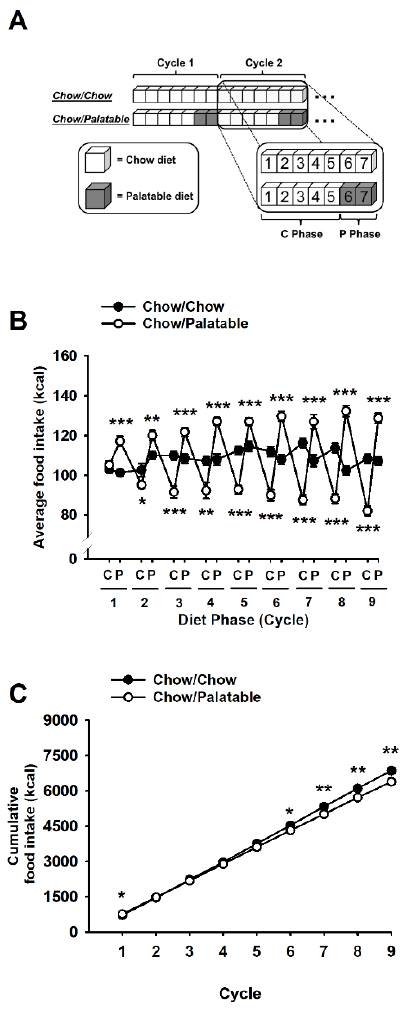
Figure 1. ( A ) Schematic representation of the experimental design used in this study. Animals were divided in two groups: one received a standard chow diet daily (Chow / Chow group) and the other group received the same standard chow for 5 days followed by a highly palatable chocolate-flavored, high sucrose diet for 2 days (Chow / Palatable group). The first 5 days when chow diet was available and the last 2 days of the weeks (when animals received either chow or palatable depending of the experimental conditions) of each week were referred as C and P phases. ( B , C ) E ff ects of repeated, alternating 5-day access to chow and 2-day access to either regular chow (Chow / Chow) or a palatable diet (Chow / Palatable) in male Wistar rats on ( B ) local and ( C ) cumulative food intake ( n = 19–20 / group). Data show M ± SEM. * p ≤ 0.05, ** p ≤ 0.01, *** p ≤ 0.001 vs. Chow /